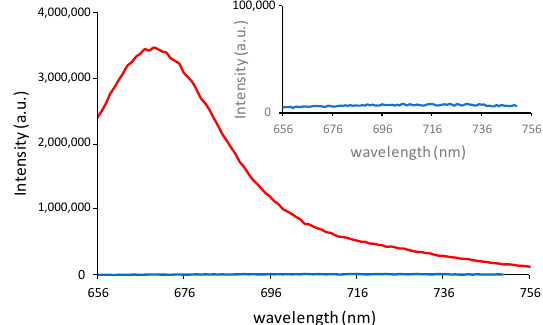
Figure 3. UV–visible spectra of aqueous suspensions containing Au@DTDTPA (black curve) and Au@DTDTPA-Cy5 (red curve) and of aqueous solution of Cy5-NH 2 (blue curve).